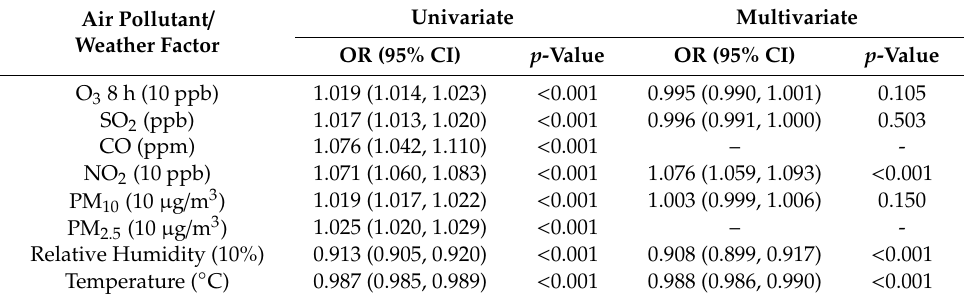
Table 3. Results of univariate and multivariate conditional logistic regression analyses for